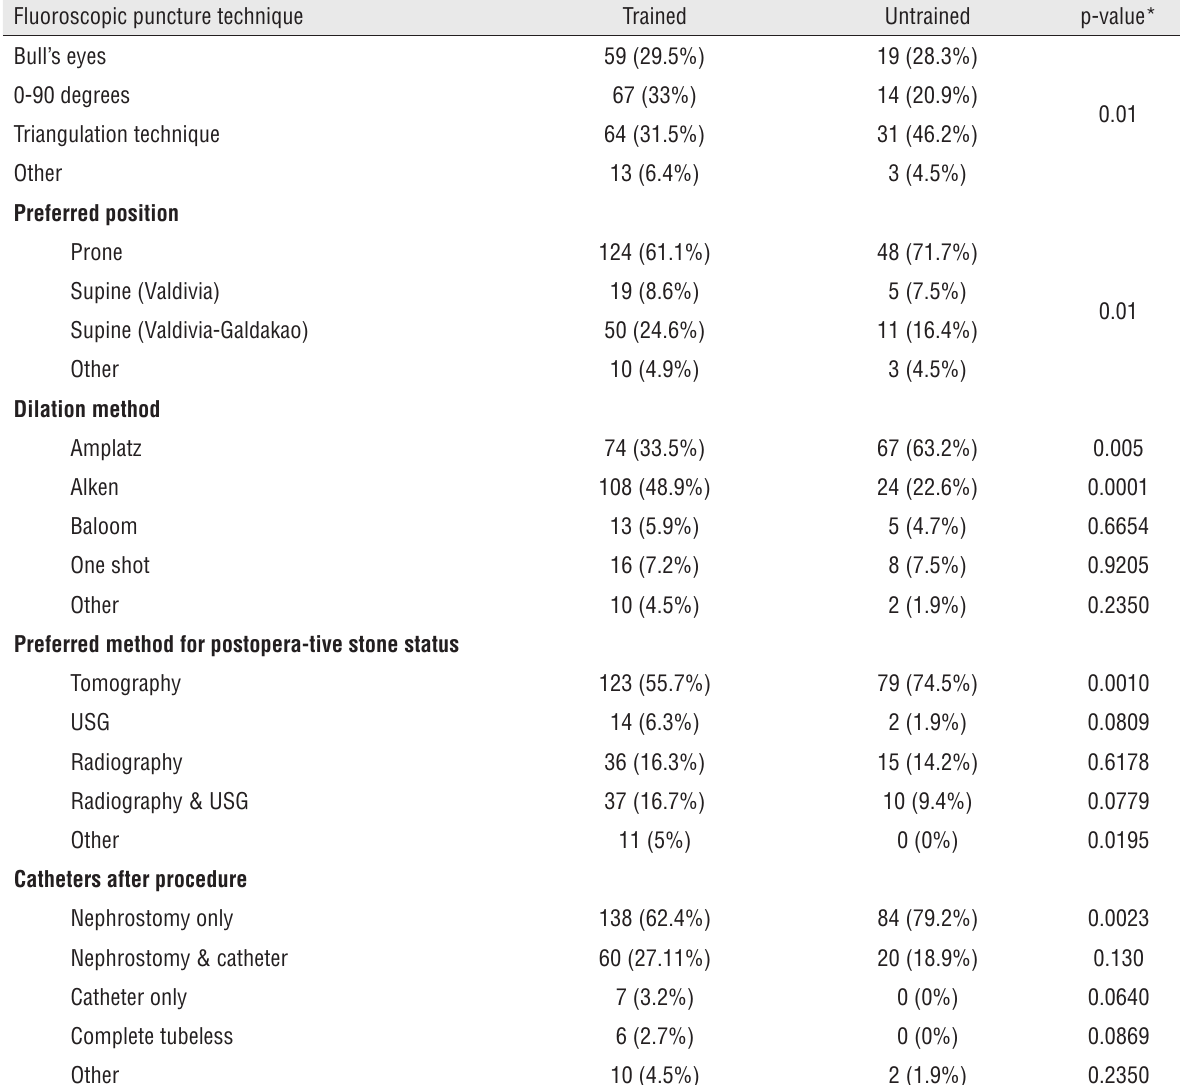
Table 3 - comparison of variables between urologists with and without endourology training. Fluoroscopic puncture technique Trained Untrained